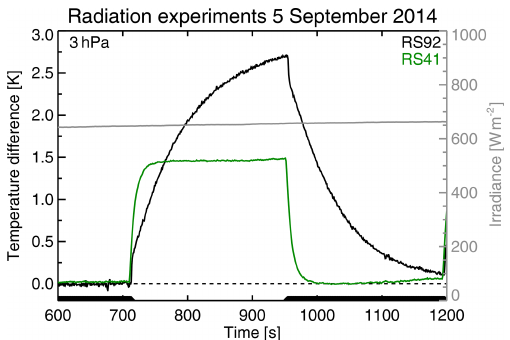
Figure 6. Results of radiation tests with the RS41 (green) and RS92 (black) radiosondes at 300hPa with 5ms − 1 ventilation flow. The solar irradiance during the test (thin grey trace) was approximately 800Wm − 2 . The thick black segments at zero temperature differ- ence indicate when the shutter was closed. During shutter open pe- riods the sensor was illuminated for 60s.